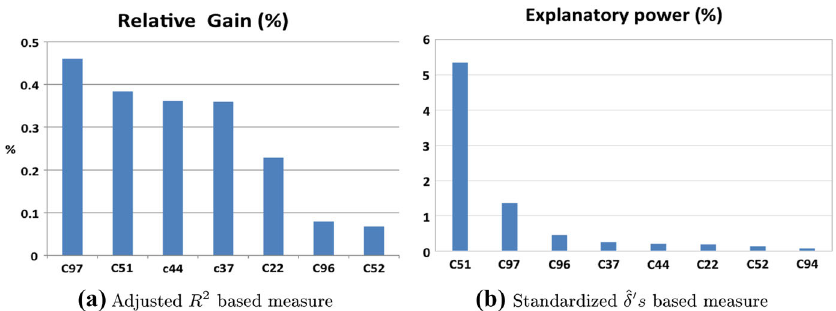
Fig. 7 Ranking of explanatory power of the variability of the Monday effect for different occupations, 2012–2017. Note units are per cent in both cases, but not